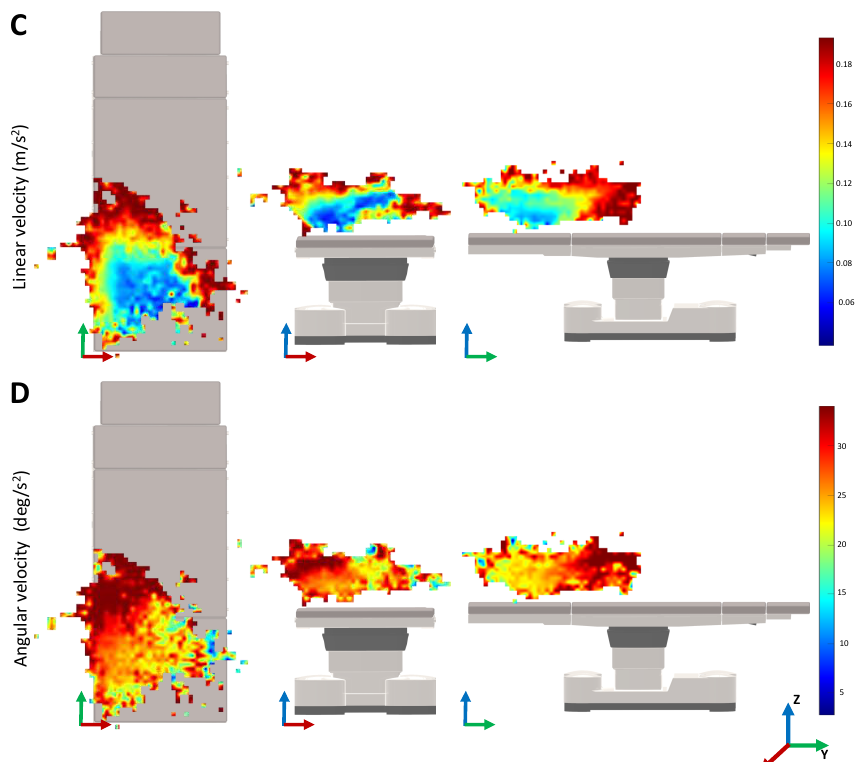
Figure 5. Limits of the operation when performing the vascular laser treatment task. The results for the common patient positioning are presented. The heatmaps for the occurrence of the treatment positions ( A ), median linear ( C ) and angular ( D ) velocities are represented for the top, front, and side views. The median value for the angle of the laser in respect to the Z-axis on each position is given for the same views ( B ).